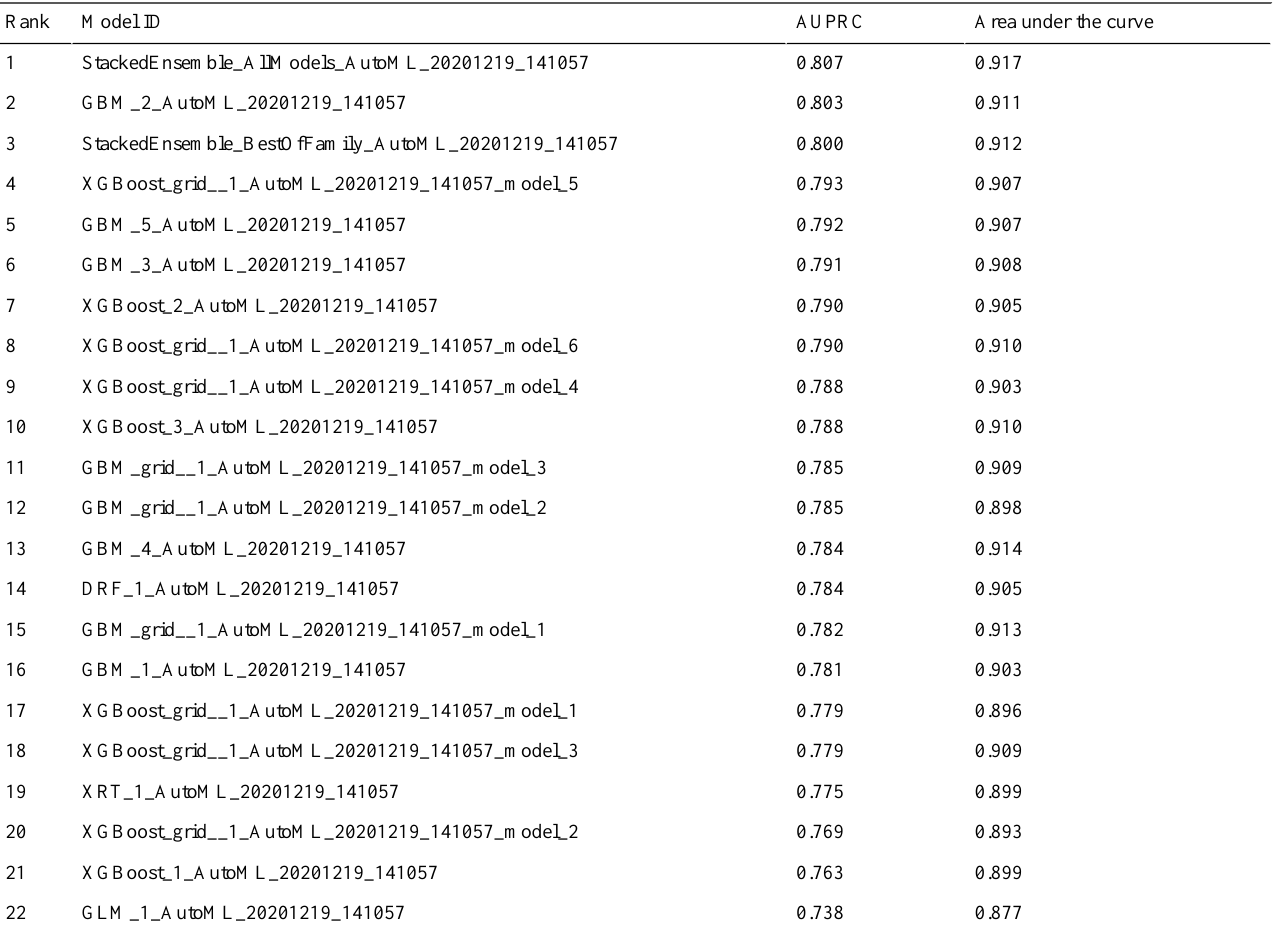
Table 2. Output of the automated machine learning models that used 48 variables. Model ranks are ordered according to AUPRCs a .